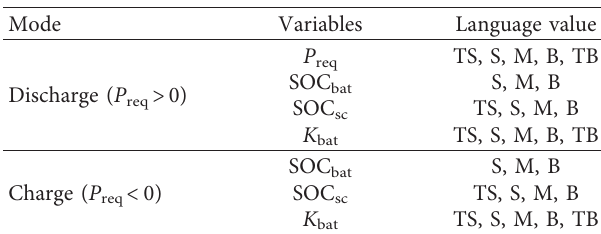
Table 3: The language value of fuzzy